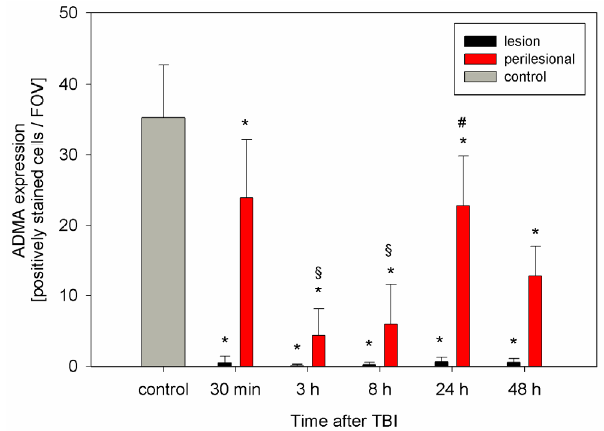
Figure 1. Expression of asymmetric dimethylarginine (ADMA) within the traumatic brain injury (TBI) lesion and perilesional area (sections of n = 5 animals at 30 min, 8 and 48 h, n = 6 at 3 and 24 h), as well as in control animals ( n = 5), shown as mean of positively stained cells per examined fields of view (FOV) at a magnification of 400× (mean ±